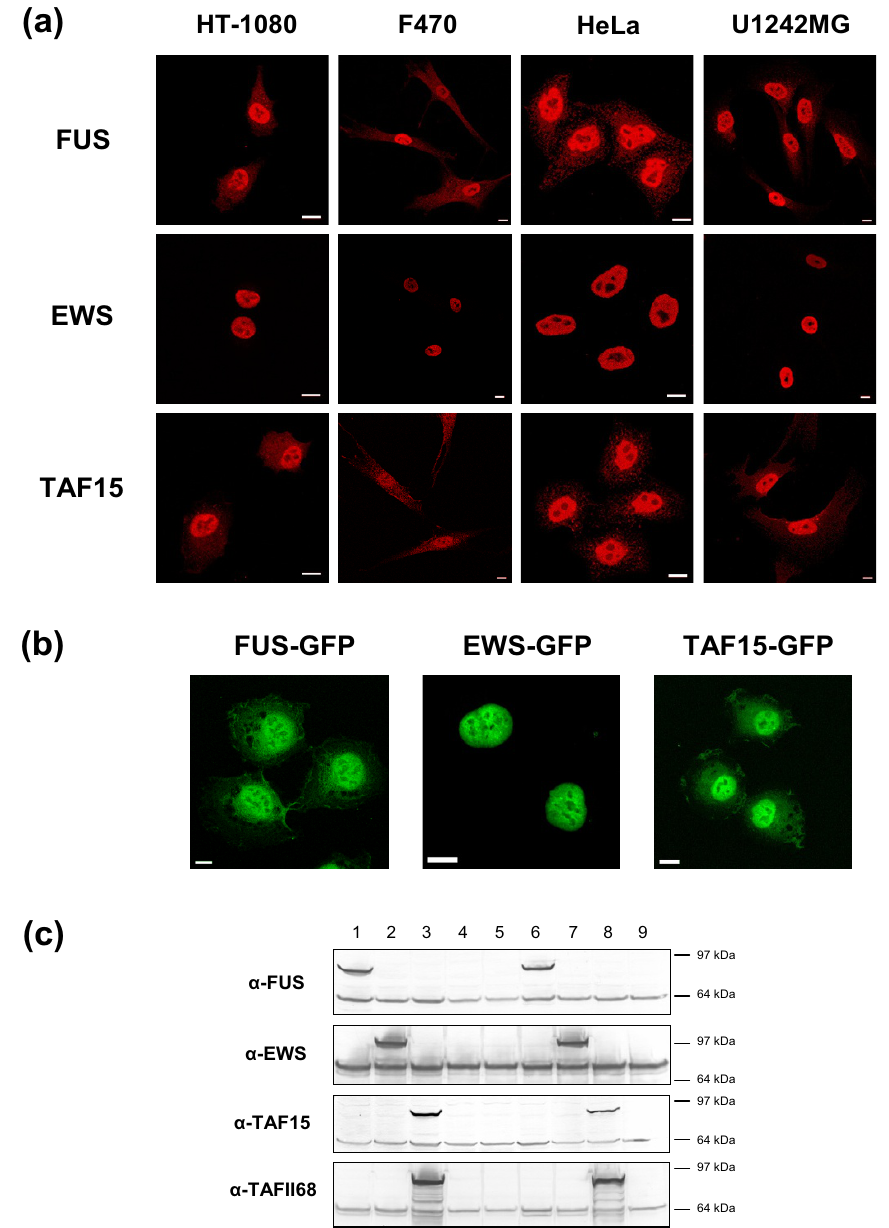
Figure 2 FET protein localization in cultured human cells . (a) Actively proliferating cells stained with antibodies for FET pro- teins. FUS and TAF15 show both nuclear and cytoplasmic localization while EWS is found solely in nuclei. Scale bars indicate 10 μ m. (b) HT-1080 cells stably expressing FET-GFP proteins show nuclear localization of all three proteins and in addition cyto- plasmic localization for FUS-GFP and TAF15-GFP. Scale bars indicate 10 μ m. (c) Western blots showing FET-GFP proteins of expected sizes and specificity of FET antibodies used. Wells contain the following lysates: FUS-GFP clone 1 (1), EWS-GFP clone 1 (2), TAF15-GFP clone 1 (3), GFP clone 1 (4), HT-1080 (5), FUS-GFP clone 2 (6), EWS-GFP clone 2 (7), TAF15-GFP clone 2 (8), GFP clone 2 (9). No crossreactivity is seen between different FET antibodies. Endogenous FET proteins correspond to the lower bands seen in all lanes and tagged FET proteins to upper bands. GFP adds approximately 27 kDa to the total size of the respective protein. FUS-GFP and EWS-GFP are expressed at slightly augmented levels compared with their endogenous coun- terparts while TAF15-GFP is expressed at much higher levels than wild type